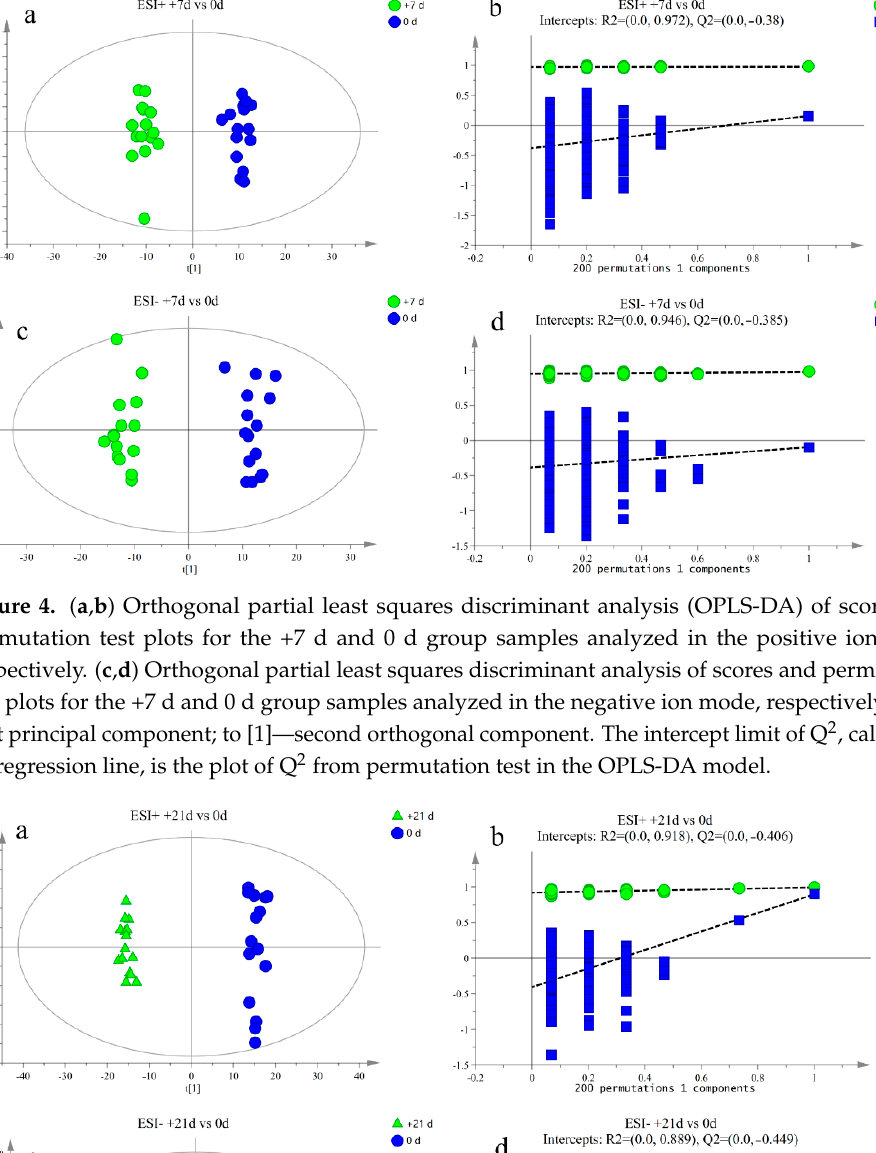
Figure 3. ( a , b ) Orthogonal partial least squares discriminant analysis (OPLS-DA) of scores and per- mutation test plots for the − 7 d and 0 d group samples analyzed in the positive ion mode, respec- tively. ( c , d ) Orthogonal partial least squares discriminant analysis of scores and permutation test plots for the − 7 d and 0 d group samples analyzed in the negative ion mode, respectively. t[1]—first principal component; to [1]—second orthogonal component. The intercept limit of Q 2 , calculated by regression line, is the plot of Q 2 from permutation test in the OPLS-DA model.